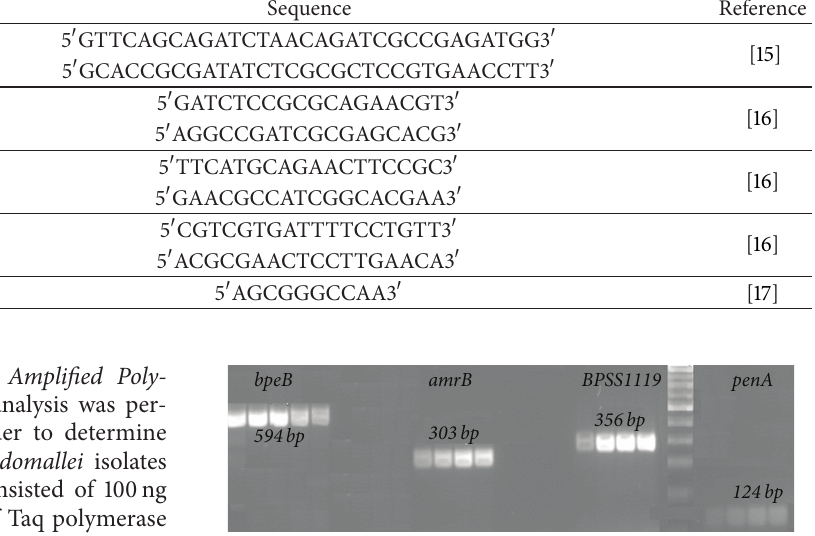
Figure 1: PCR results demonstrating the agarose gel electrophoretic analysis of PCR products generated from amplification of efflux pump genes ( bpeB , amrB , and BPSS1119 ) and class A 𝛽 -lactams gene ( penA ) from B. pseudomallei . The presence of a 594 bp, 303 bp, 356 bp, and 124 bp fragments in the agarose gel indicated a positive result for bpeB , amrB , BPSS1119 , and penA , respectively. Ladder: 100 bp ladder (MBI Fermentas,